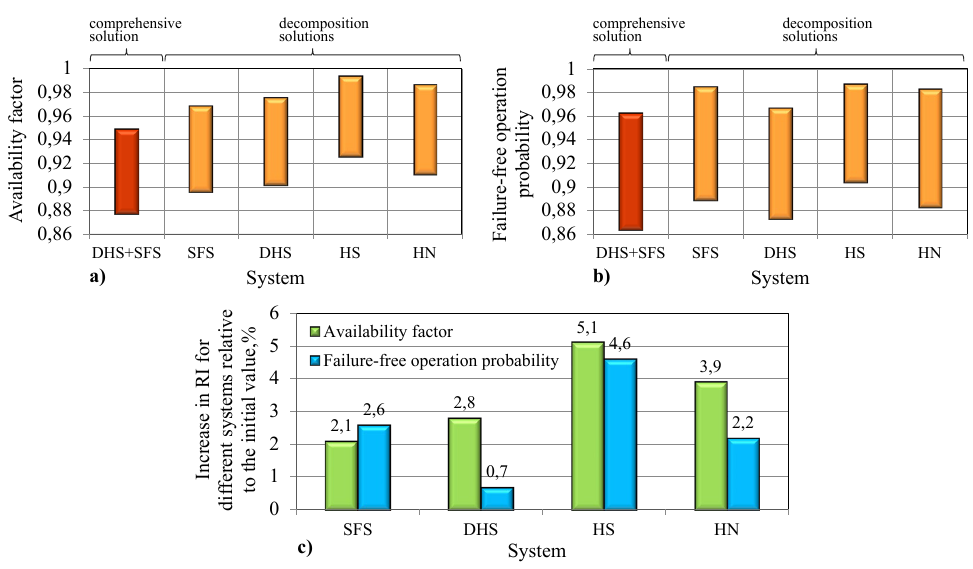
Fig. 10. Summarizing result of a comprehensive and decomposition analysis of the reliability of DHS (heat supply to consumers) in Shelekhov: a) range of K values; b) range of R values; c) average values of the increase in nodal RI for subsystems in relation to the level of indices of the jointed system